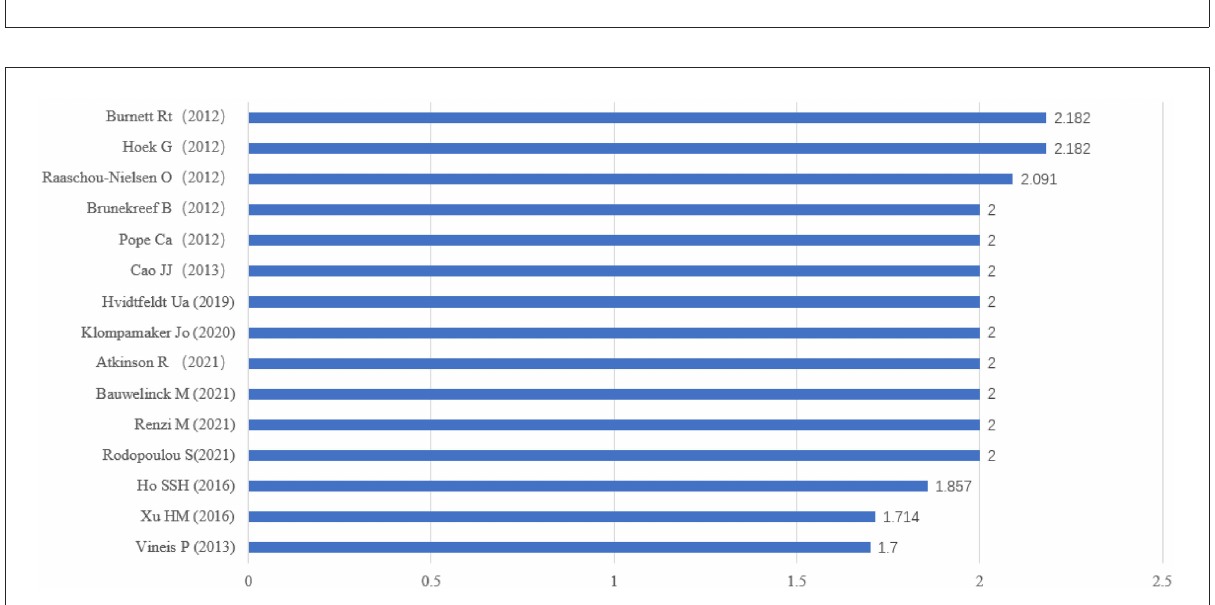
FIGURE1 Temporal changes of the number of publication and average citation per year.